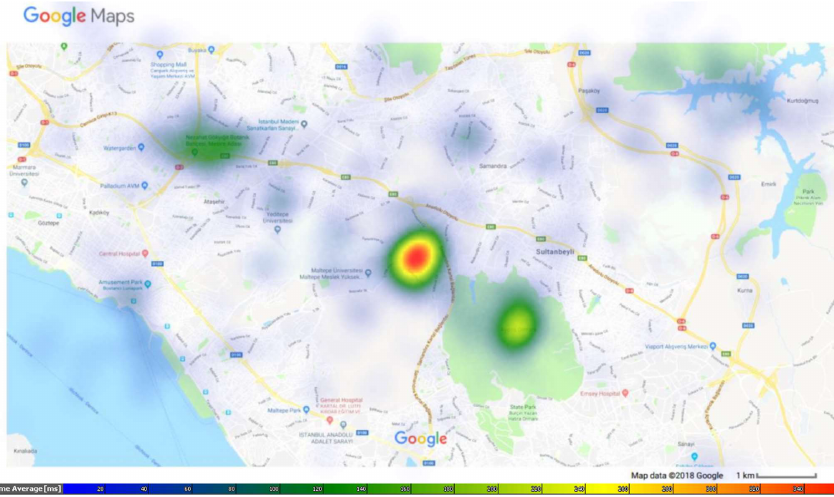
Figure A5. Larger version of Figure 8e. ISPRS Int. J. Geo-Inf. 2023 , 11 , x FOR PEER REVIEW